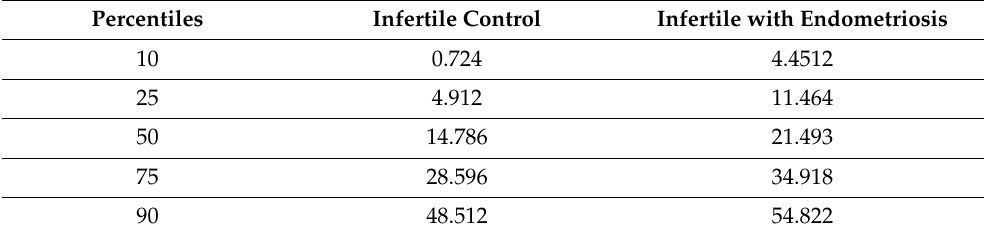
Figure 3. BCL6 expression in the endometrium of infertile patients with and without endometriosis: ( A ) representative images of BCL6 expression ( 50 µm); ( B ) HSCOREs in the endometrium of infertile women without endometriosis (controls, n = 29 and infertile patients with endometriosis ( n = 17); ( C ) mean normalized BCL6 intensity distributions measured on all scanned sections in each group of patients. * p ≤ 0.05, ** p ≤ 0.01, and *** p ≤ 0.001. Table 4. Percentiles of BCL6 intensity and distribution in infertile patients without or with associated endometriosis.